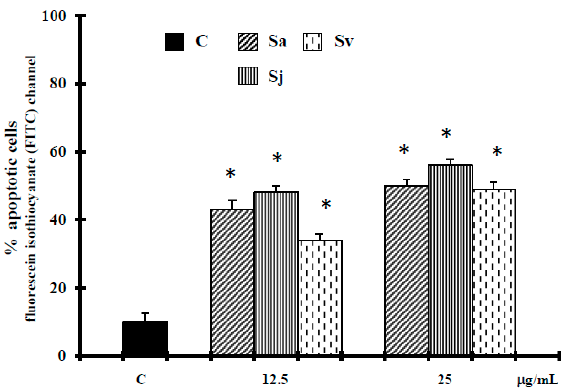
Figure 4. Terminal deoxynucleotidyl transferase (TdT)-mediated dUTP nick-end-labeling (TUNEL) assay in DU-145 cells untreated and treated with different concentrations of the essential oils from Sa, in quadruplicate. * Significant vs. control untreated cells ( p < 0.001). ( Bax), B-cell lymphoma 2 (Bcl-2), caspase-9 and caspase-3 are modulated for programmed cell death